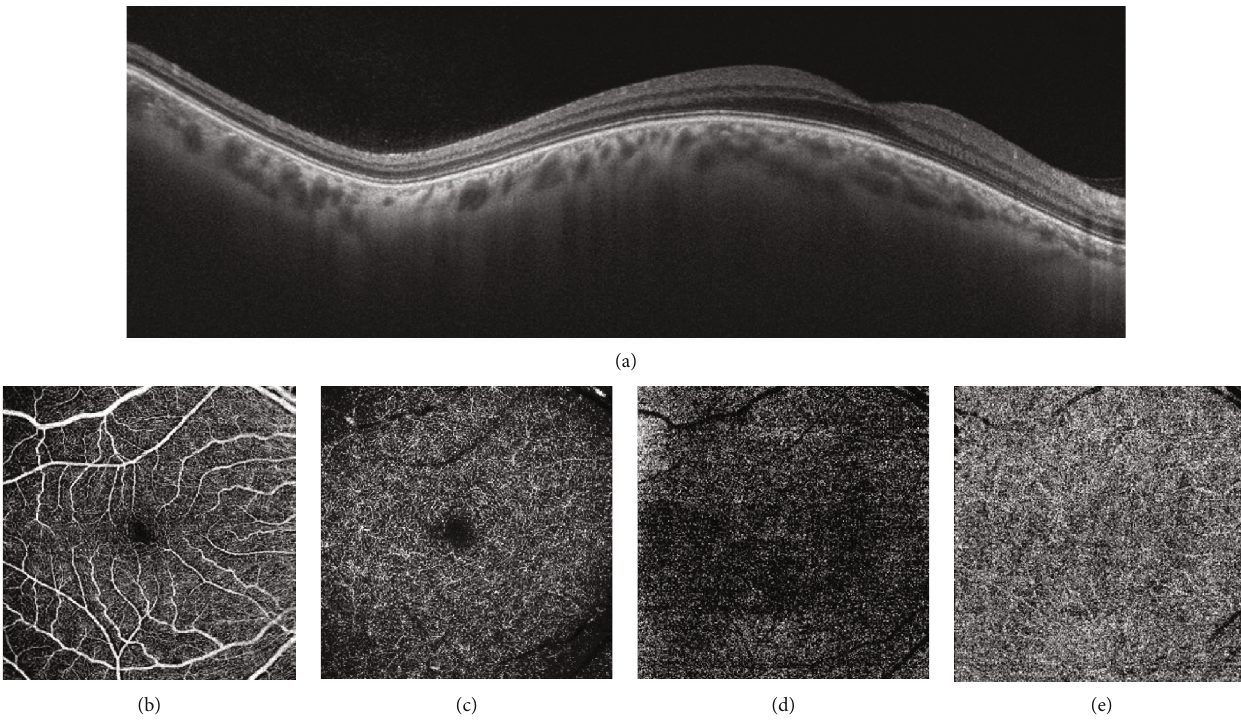
Figure 2: (a) Swept-source optical coherence tomography through the fovea reveals a smooth contoured elevation of the posterior pole without any distortion of retinal structures, giving a dome-shaped maculopathy-like appearance. (b-e) Swept-source optical coherence tomography angiography images of super fi cial retinal plexus (b), deep retinal plexus (c), outer retina (d), and choriocapillaris (e) show normal retinal and choroidal vasculature